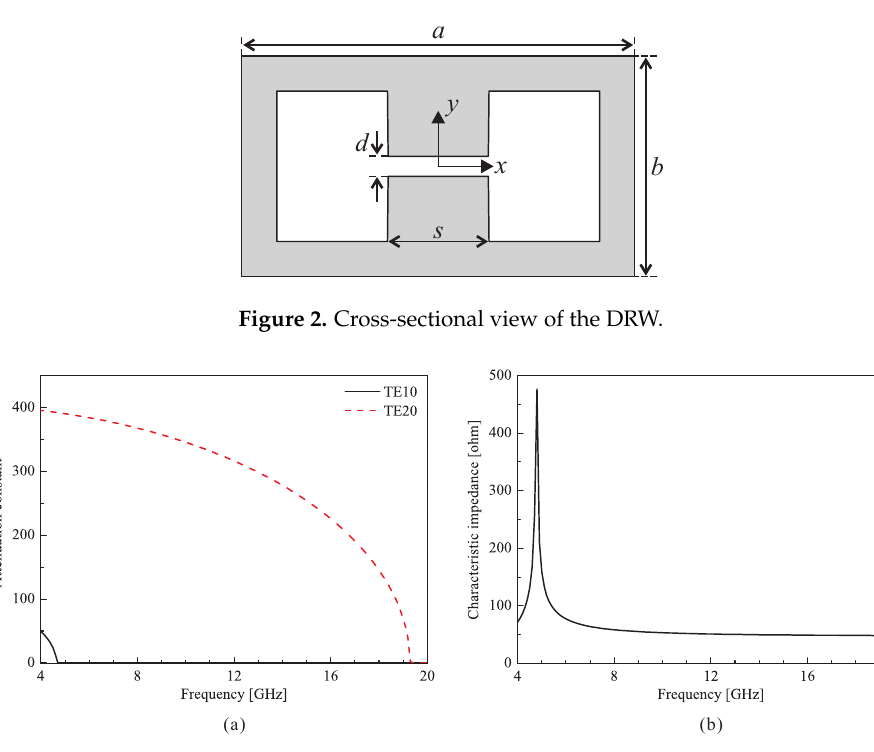
Figure 3. Simulated results of the DRW: ( a ) attenuation constant and ( b ) characteristic impedance.